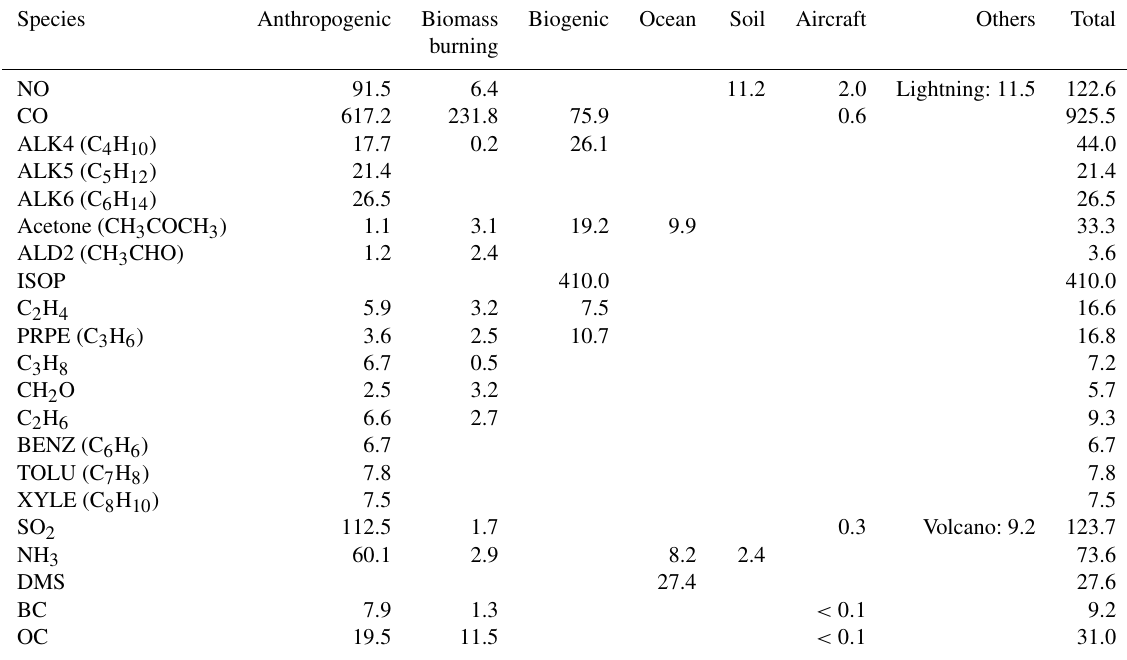
Table 2. Global annual emissions used in the BCC-GEOS-Chem v1.0 categorized by sectors (in Tgyr − 1 ). Species Anthropogenic Biomass Biogenic Ocean Soil Aircraft Others Total burning NO 91.5 11.2 Lightning: 11.5 122.6 CO